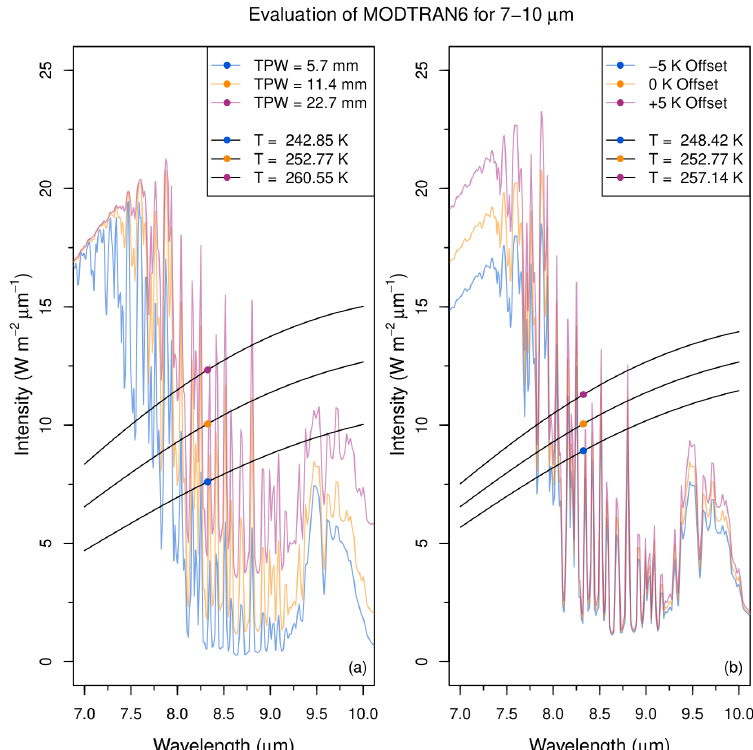
Figure 7. (a) Downward radiances at the surface, located 1.4km above sea level, computed using MODTRAN6 with a midlatitude summer model atmosphere. Water vapor was uniformly scaled to produce a PWV of 5.7mm (blue), 11.4mm (orange), and 22.7mm (purple), with all other model parameters held constant. Also plotted are blackbody curves for three different temperatures (black), with each curve having the same integrated radiance as the corresponding MODTRAN6 radiance ( T b = 260 . 55, 252.77, and 242.85K for PWV = 22 . 7, 11.4, and 5.7mm, respectively). (b) Same as (a) but for uniform changes in atmospheric temperature of ± 5K with water vapor held constant at PWV = 11 . 4mm. Equivalent blackbody temperatures are T b = 257 . 14, 252.77, and 248.42K for the case of (cid:49)T b = + 5, 0, and − 5K,